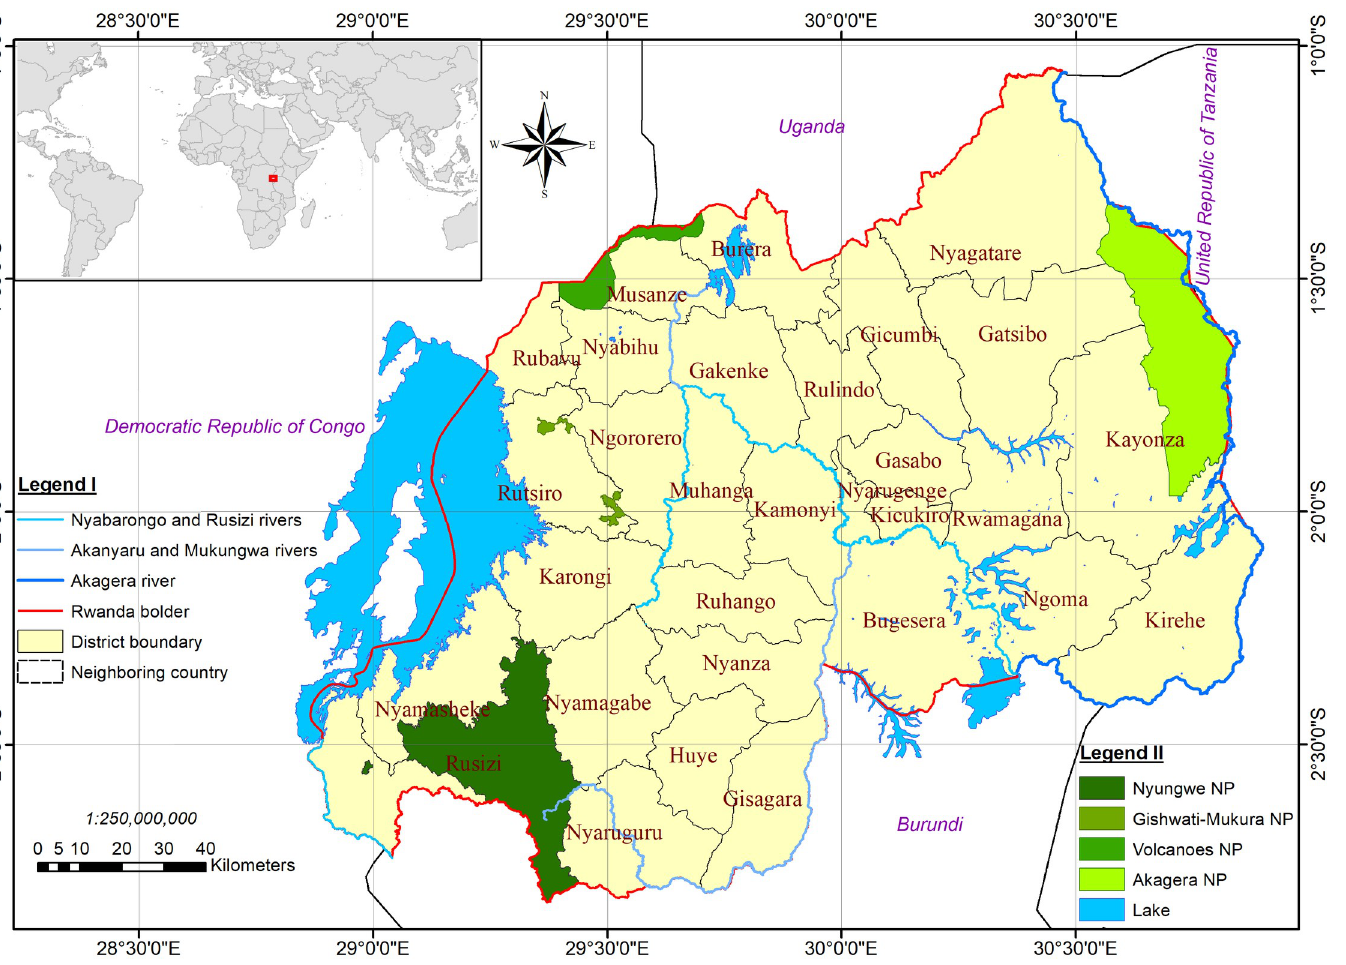
Fig 1. The map depicting the study area and its NP